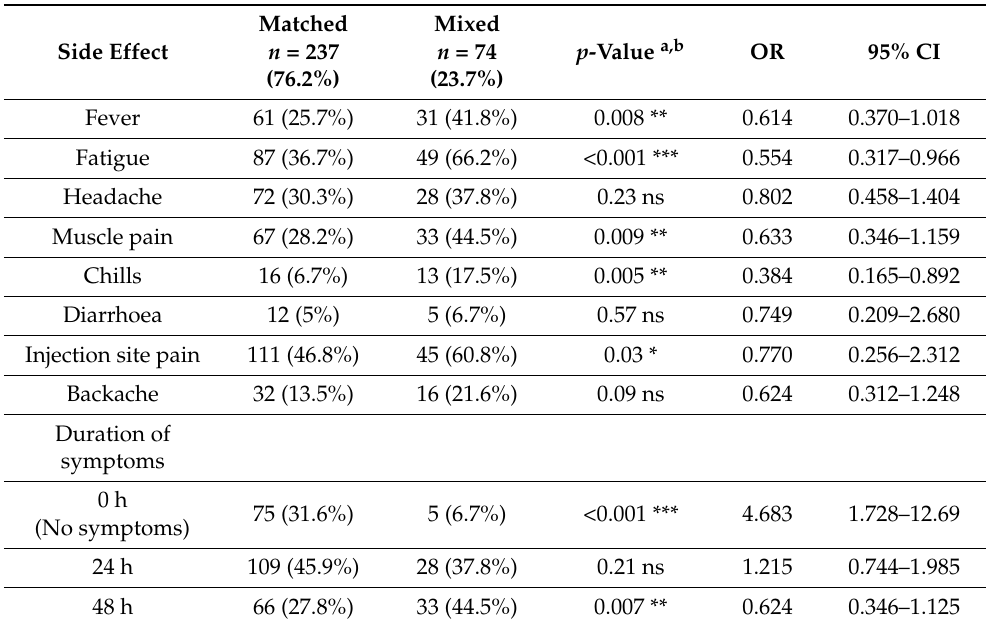
Table 2. The adverse effects after the second dose between participating groups who matched or mixed COVID-19 vaccines. The table illustrates the adverse effects after the second dose between groups who matched or mixed COVID-19 vaccines, including the BNT162b2 (Pfizer–BioNTech) and the ChAdOx1 (AstraZeneca) vaccines. The table shows the frequency of no symptoms after the second dose between participants who matched or mixed the first and the second dose with either BNT162b2 (Pfizer–BioNTech) or ChAdOx1 (AstraZeneca) vaccines, respectively. Furthermore, the table shows the duration of symptoms in participating groups after the second dose between matched and mixed vaccines. Statistical analysis was performed using the chi-square test. * p < 0.05, ** p < 0.01, *** p < 0.001, ns = not significant. a Derived from chi-square test. b Level of significance (alpha) = 0.05. h =